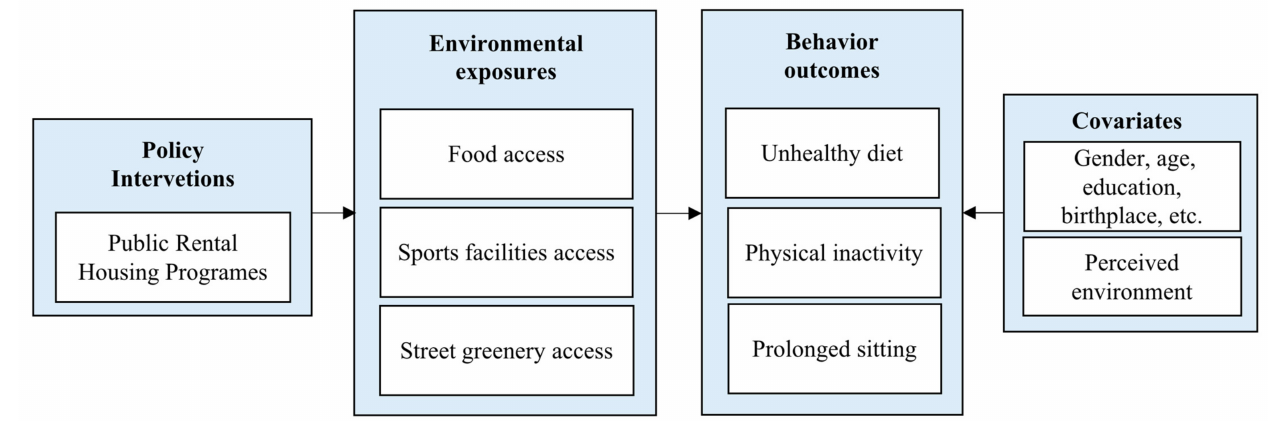
Figure 1. Conceptual framework of direct and indirect pathways through which public rental housing programs influence obesogenic